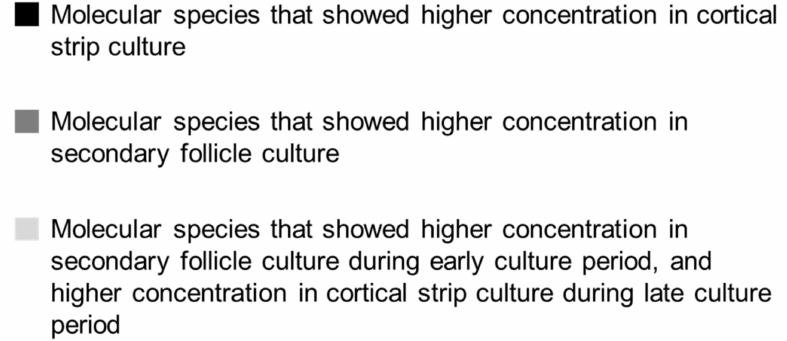
Figure 9. The molecular species that showed differences between the cortical strip culture and secondary follicle cultures. All molecules detected by the free amino acid analysis were categorized as essential amino acids, non-essential amino acids, non-proteinogenic amino acids, and other molecules. Concentrations of these molecules were compared between cortical strip culture for primordial activation and secondary follicle culture. Molecules in the black area were higher in cortical strip culture than in secondary follicle culture throughout the culture period. Molecules in the dark gray area were higher in secondary follicle culture than in cortical strip culture. Molecules in the light area were higher in secondary follicle culture than in cortical strip culture during the early culture period, then became higher in fragment culture than in secondary follicle culture during the late culture